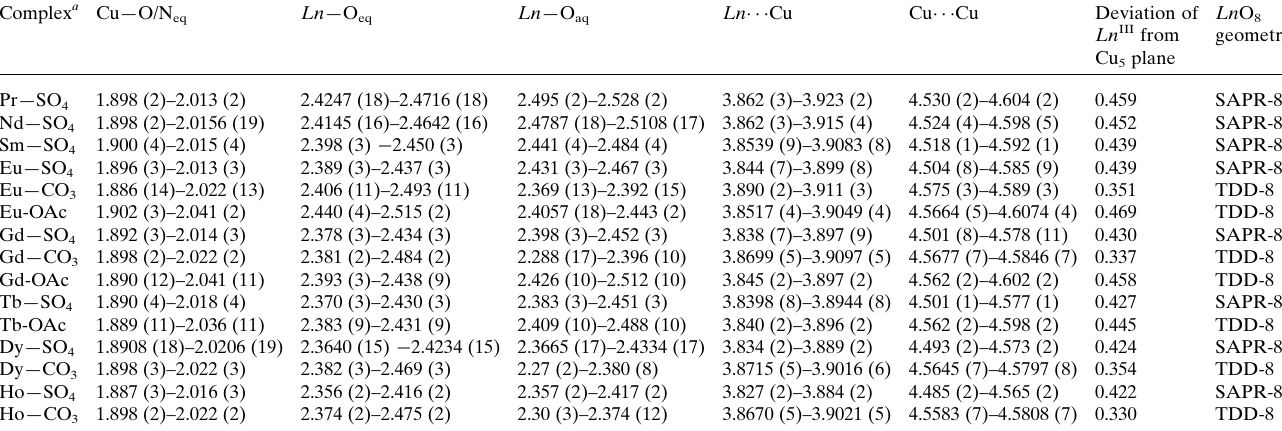
Table 2 Comparison of the structural characteristics (A˚ , (cid:5) ) of { Ln Cu 5 } 3+ 15-metallacrown-5 complexes with octacoordinate Ln III ions and various bidentate anions.